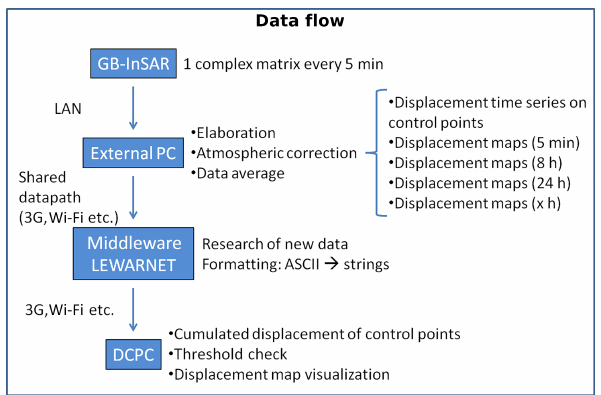
Figure 3. Diagram showing the complete data flow from acquisition to final